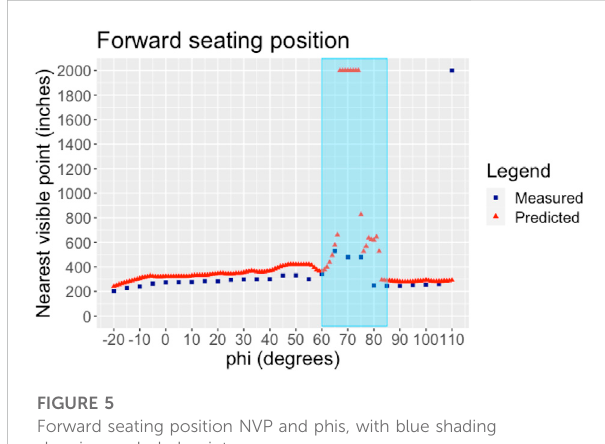
FIGURE 5 Forward seating position NVP and phis, with blue shading showing excluded